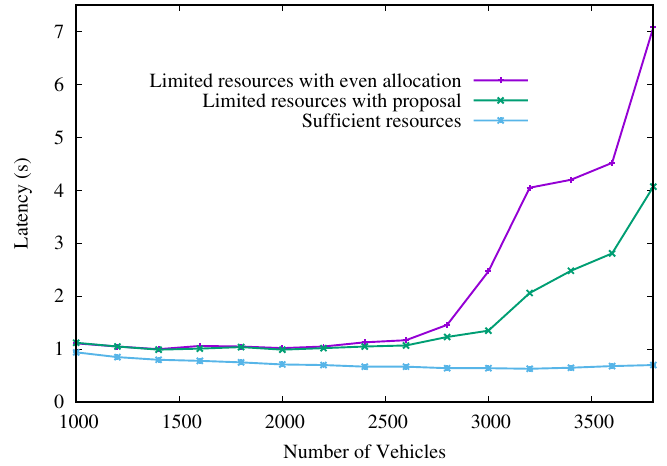
Figure 7. Latency performance of the system without coexisting